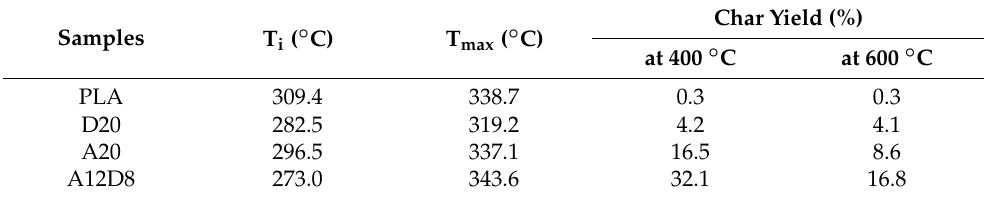
Table 2. TGA and DTG data for PLA, D20, A20 and A12D8.